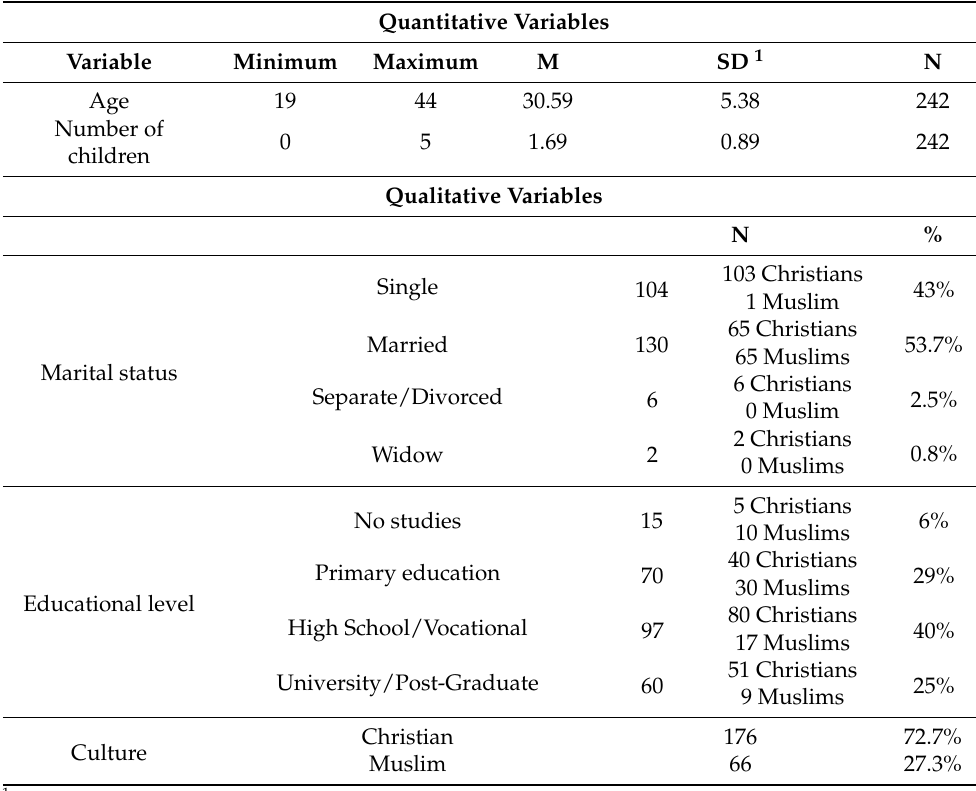
Table 1. Description of sociodemographic